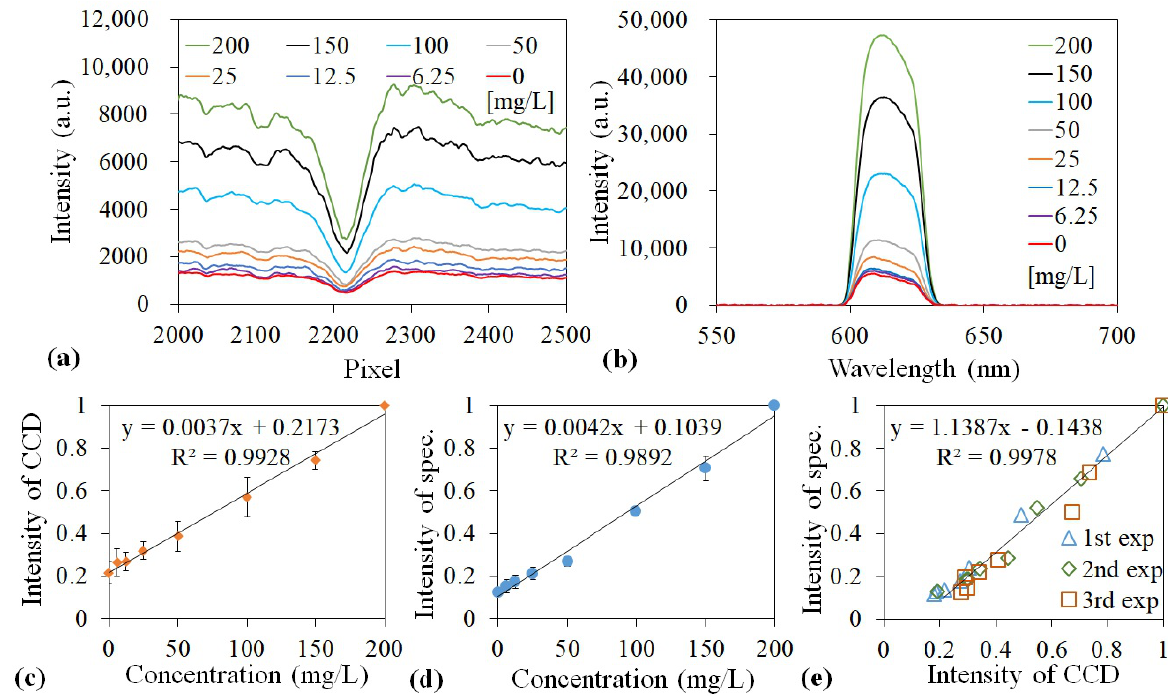
Figure 6. Intensity measured with the ( a ) GGP-GMR/CCD system and ( b ) spectrometer for different human serum albumin (has) concentrations. Normalized intensities for the ( c ) MICP and ( d ) peak wavelength as a function of the HSA concentration. ( e ) This figure depicts the correlation between the HSA measurements obtained from the spectrometer and GGP-GMR/CCD